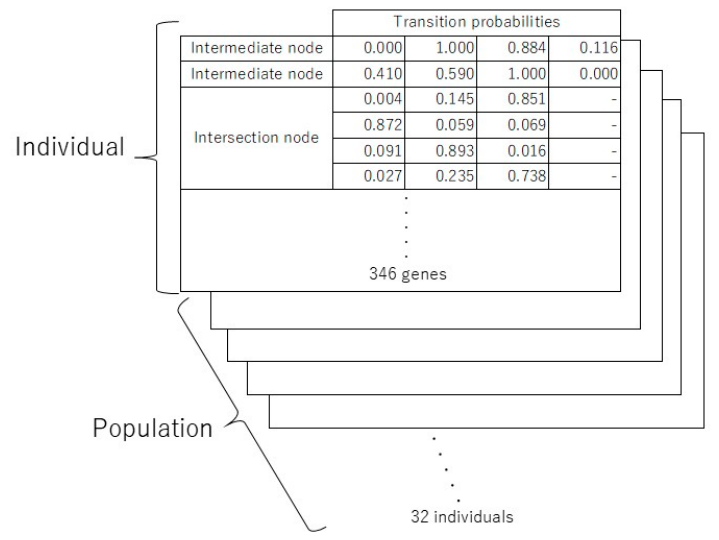
Figure 6. Examples of genes, individuals, and population.